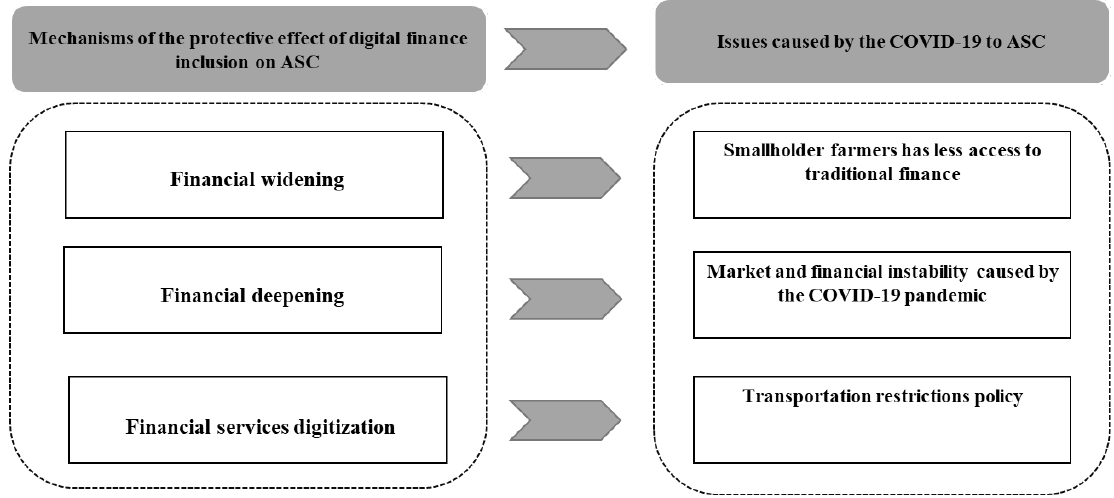
Figure 1. Mechanisms of the protective effect of digital finance inclusion on ASC.